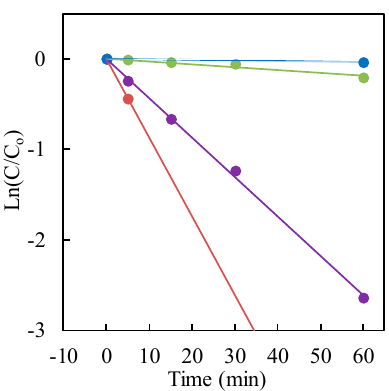
Figure 6. − ln(C/C 0 ) versus irradiation time. Cr(VI) sample: 30 μ g·mL − 1 (30 mL); TiO 2 : 20 mg (0.67 mg·mL − 1 ). With formic acid hole scavenger: red for Ishihara Sangyo ST-01; purple for AEROXIDE® P25TiO 2 ; green for FUJIFILM Wako Pure Chemical Corp. Without hole scavenger: blue for AEROXIDE® P25TiO 2 .